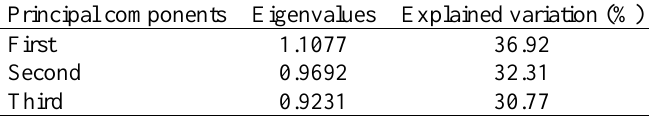
Table 6. The eigenvalues and explained variation for principal